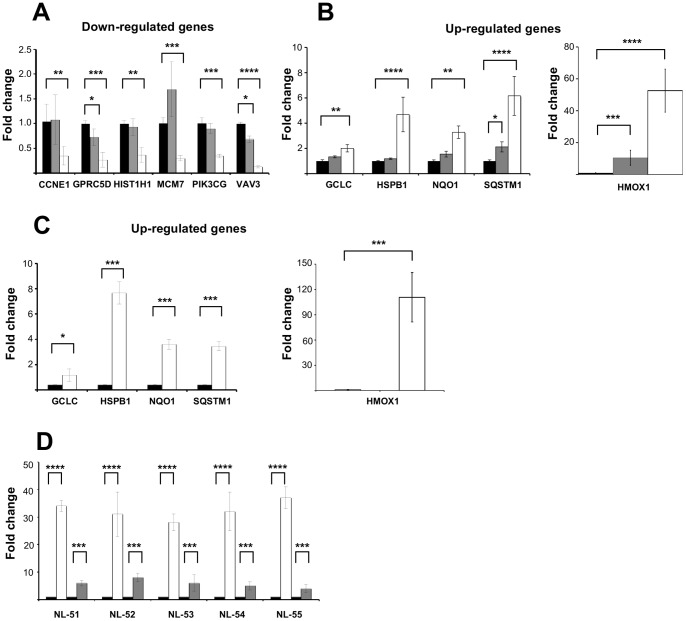
Validation of genes with altered expression after iAs exposure.Total RNA from CL-1 cell lines exposed to 5 µM of iAs for 2 and 12 h of exposure as indicated was used as template for RT-qPCR assays. Control: black bars, 2 hrs: grey bars and 12 hrs: white bars. A) Down-regulated genes, B) Up-regulated genes, C) Overexpressed genes in CL-45 cell lines treated with 5 µM of iAs for 12 hrs. Control: black bars, treated: white bars. D) Expression levels of HMOX1 and NQO1 genes in lymphoblastoid primary cultures with 5 µM of iAs for 12 hrs. Control: black bars, HMOX1: white bars and NQO1: grey bars. Data values are means ± SD and were normalized using GADPH as an endogenous gene. Fold change was related to untreated samples. Three independent cell cultures were used for each assay. **** p<0.001, *** p<0.005, ** p<0.01, * p<0.05.